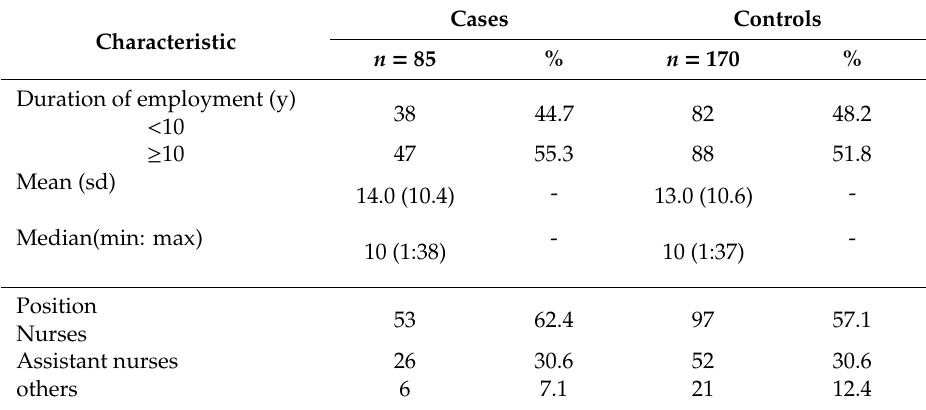
Table 2. Characteristics of risk factors for LTBI by cases and